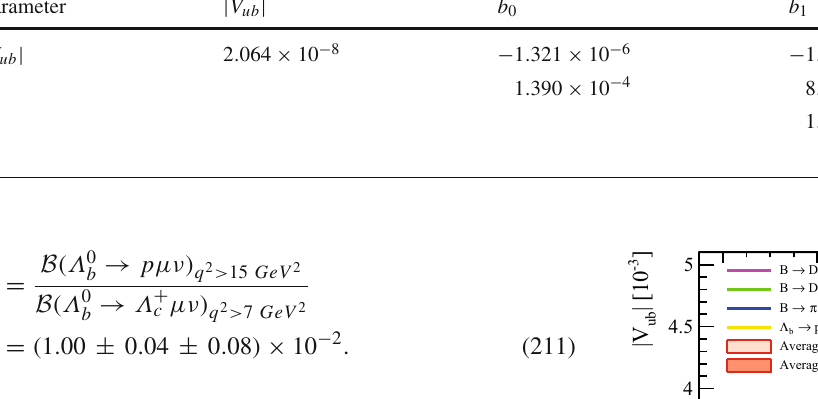
Table 84 Covariance matrix for the combined fit to data, LQCD and LCSR results Parameter